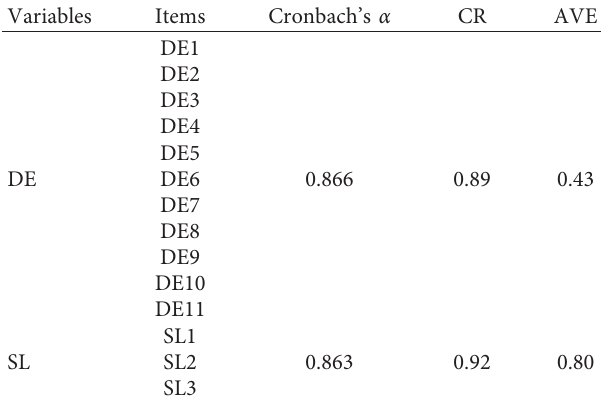
Table 2: Reliability and validity analysis of